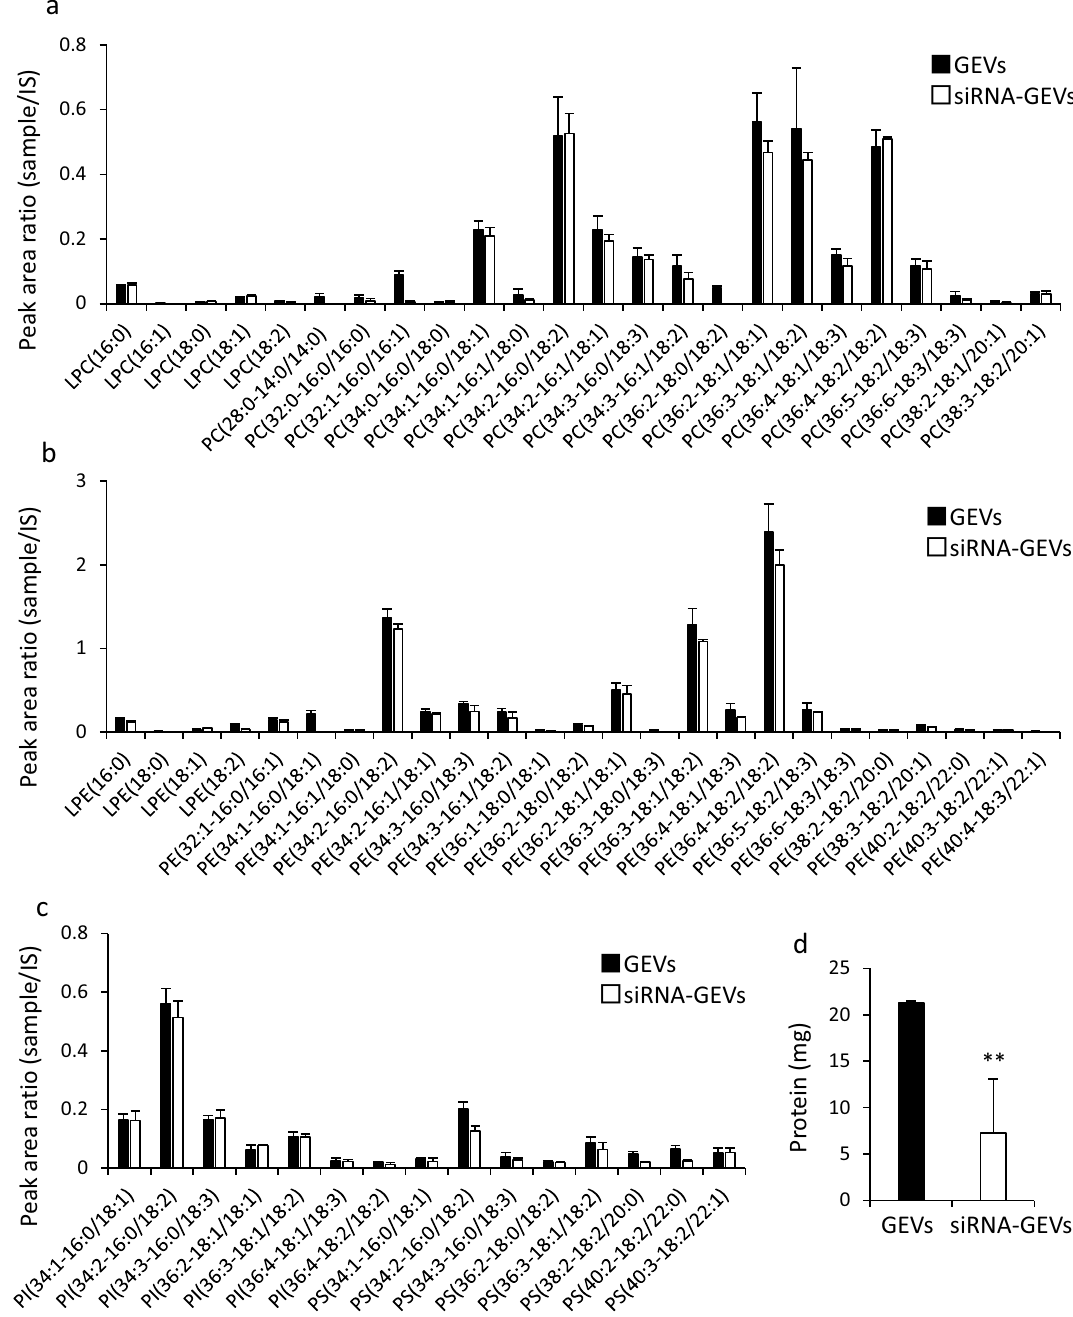
Figure 5. Evaluation of phospholipids and proteins in siRNA-GEVs compared with those in GEVs. ( a ) Analysis of phospholipids in GEVs and siRNA-GEVs by liquid chromatography-tandem mass spectrometry (LC–MS/MS). The data are shown as peak area ratios of ( a ) lysophosphatidylcholine and phosphatidylcholine (PC), ( b ) lysophosphatidylethanolamine and phosphatidylethanolamine (PE), ( c ) phosphatidylinositol (PI) and phosphatidylserine (PS), and ( d ) phospholipids in GEVs and siRNA-GEVs. The data are presented as the mean ± S.D. (n = 3) ( b ) The protein contents of siRNA-GEVs and GEVs were measured using BCA assay. The data are presented as the mean ± S.D., **p < 0.01 (n =